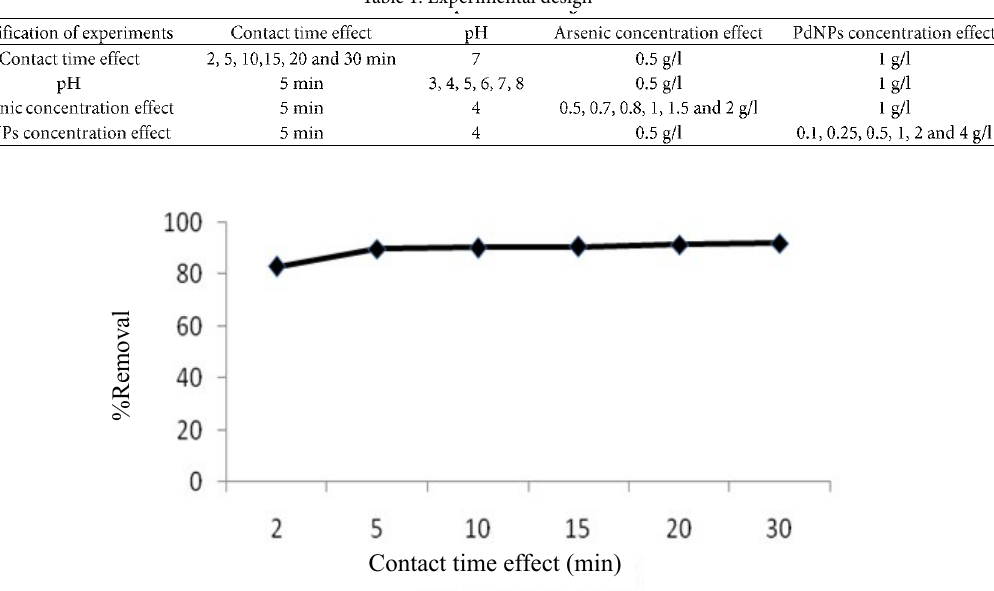
Fig. 1. Effect of contact time on